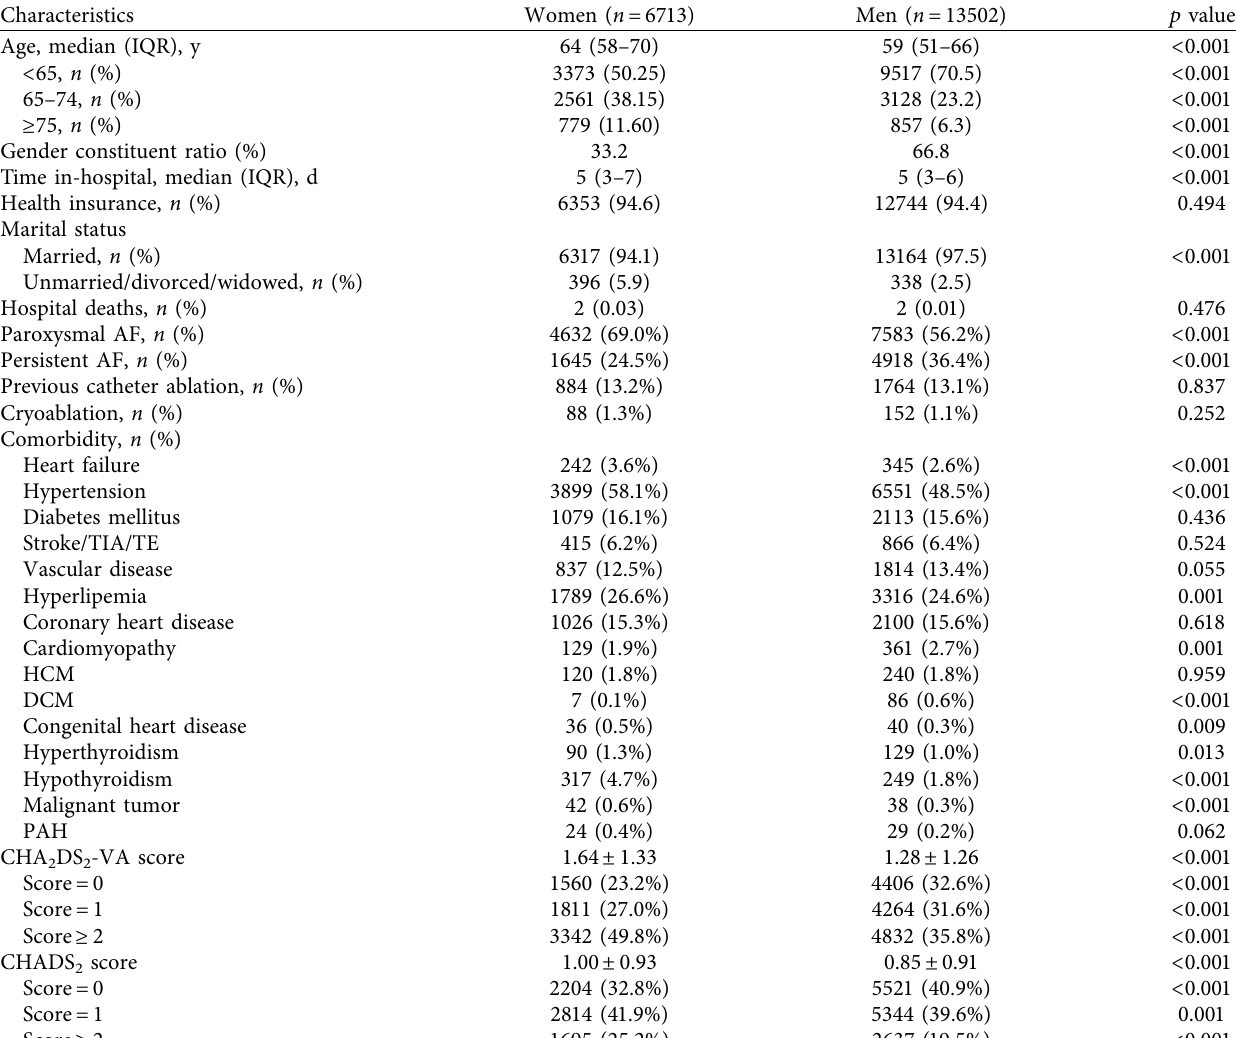
Figure 1: Trends in the number and sex ratio of patients undergoing catheter ablation for atrial fibrillation according to sex. Table 1: Baseline characteristics of AF patients by